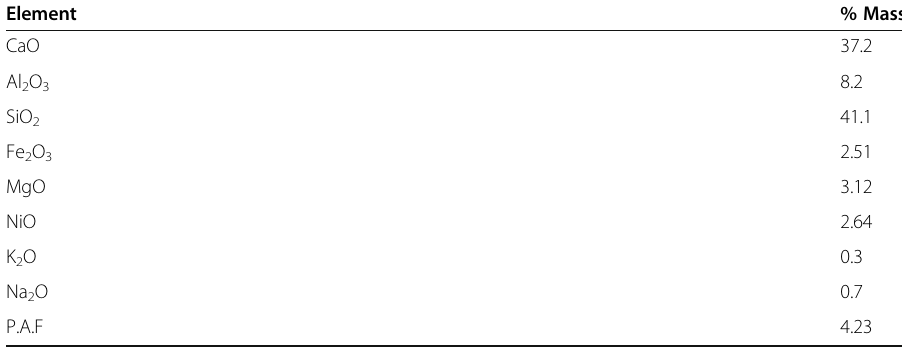
Table 1 Chemical composition of BF slag